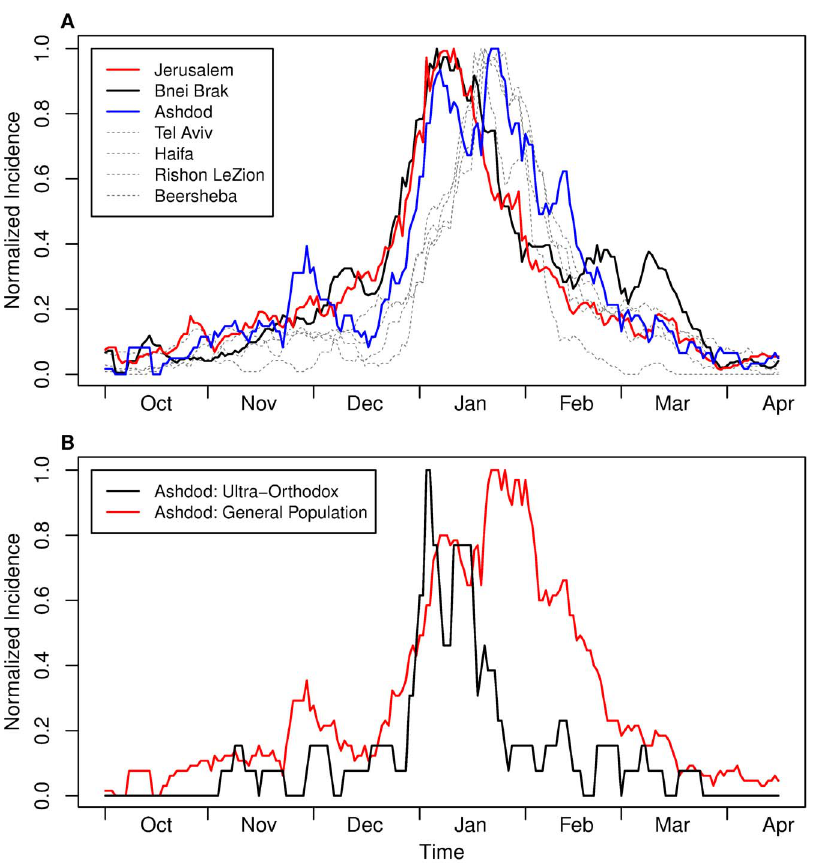
Figure 5. ILI incidence in the ultra-orthodox population during the 2001 – 2002 season. (A) ILI incidence in Jerusalem (red), Bnei Brak (black), Ashdod (blue) and Israel’s main cities – Tel Aviv, Haifa, Rishon LeZion and Beersheba (dashed gray). Incidence curves were normalized by dividing each incidence curve to its own maximum in order to equalize all maxima and emphasize the degree of synchrony. Note early January peak in Jerusalem and Bnei Brak, a later January peak in all other cities, and a double peak in Ashdod. (B) ILI incidence in same season in the two different population groups of Ashdod: Ultra-Orthodox (black) and the general population (red). The General population of Ashdod shows a similar incidence curve to other non-Orthodox cities, while the ultra-orthodox parts of the city resemble the cities which large ultra-orthodox communities. doi:10.1371/journal.pone.0091909.g005 PLOS ONE |